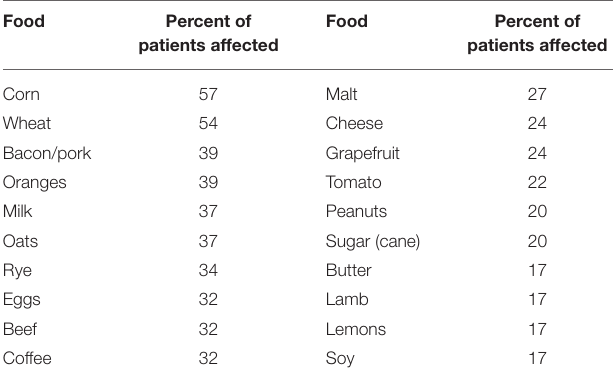
TABLE 2 | Foods inducing symptoms in food-reactive RA patients ( n =